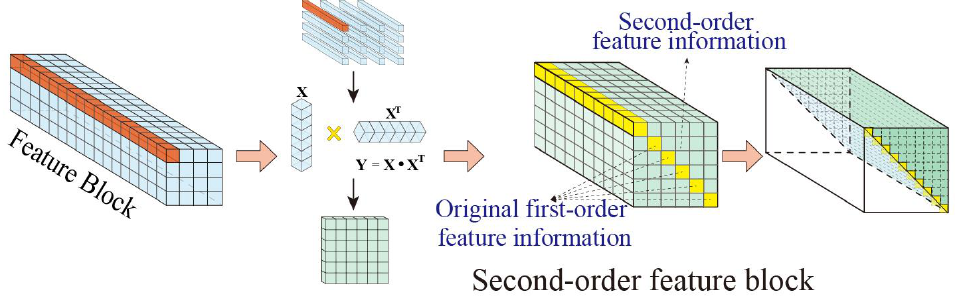
Figure 18. Second-order pooling contained the feature information of traditional pooling methods.